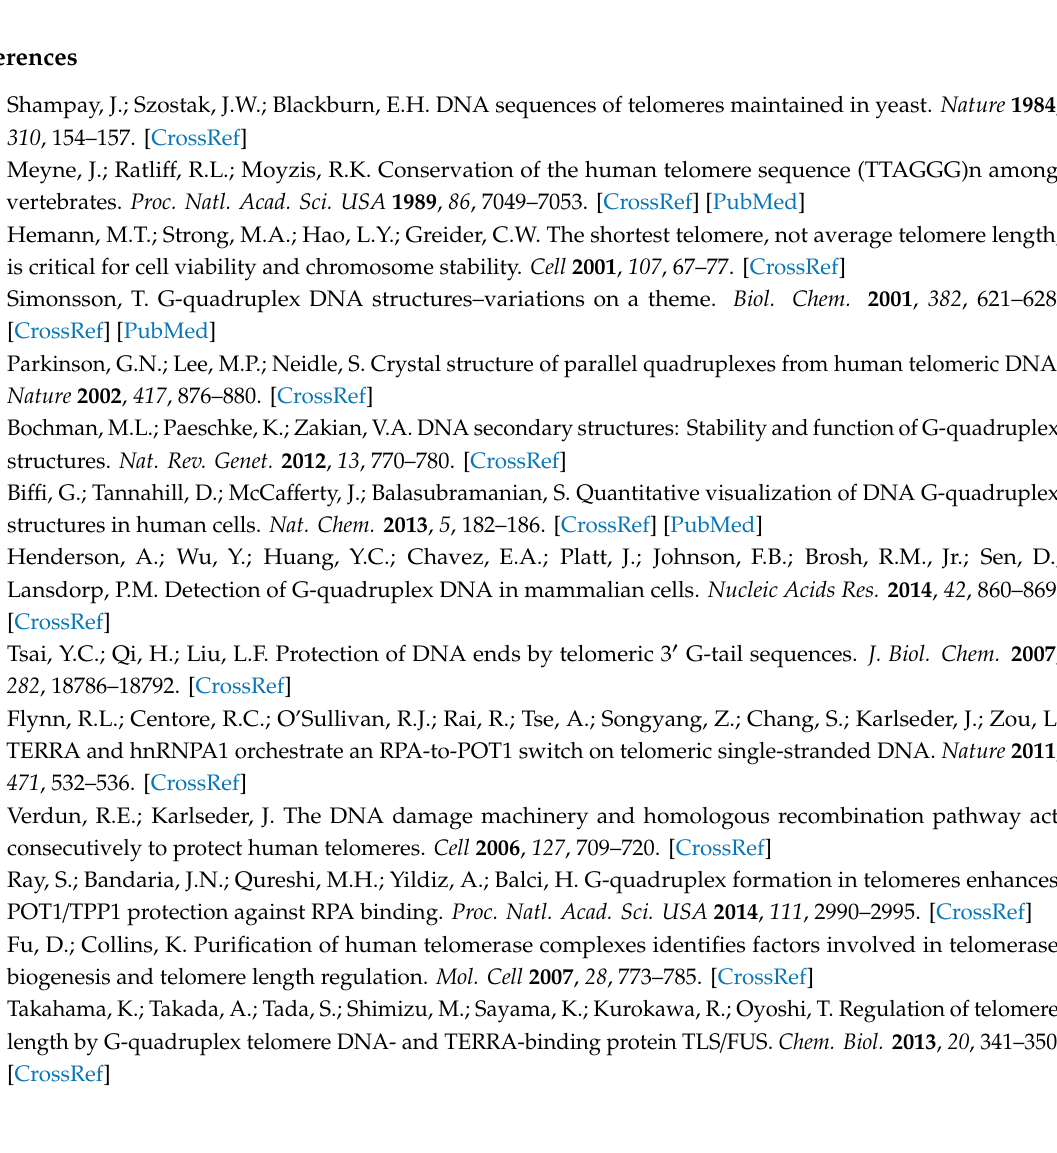
Figure S1: Standard curve for qPCR. Figure S2: Standard curve for